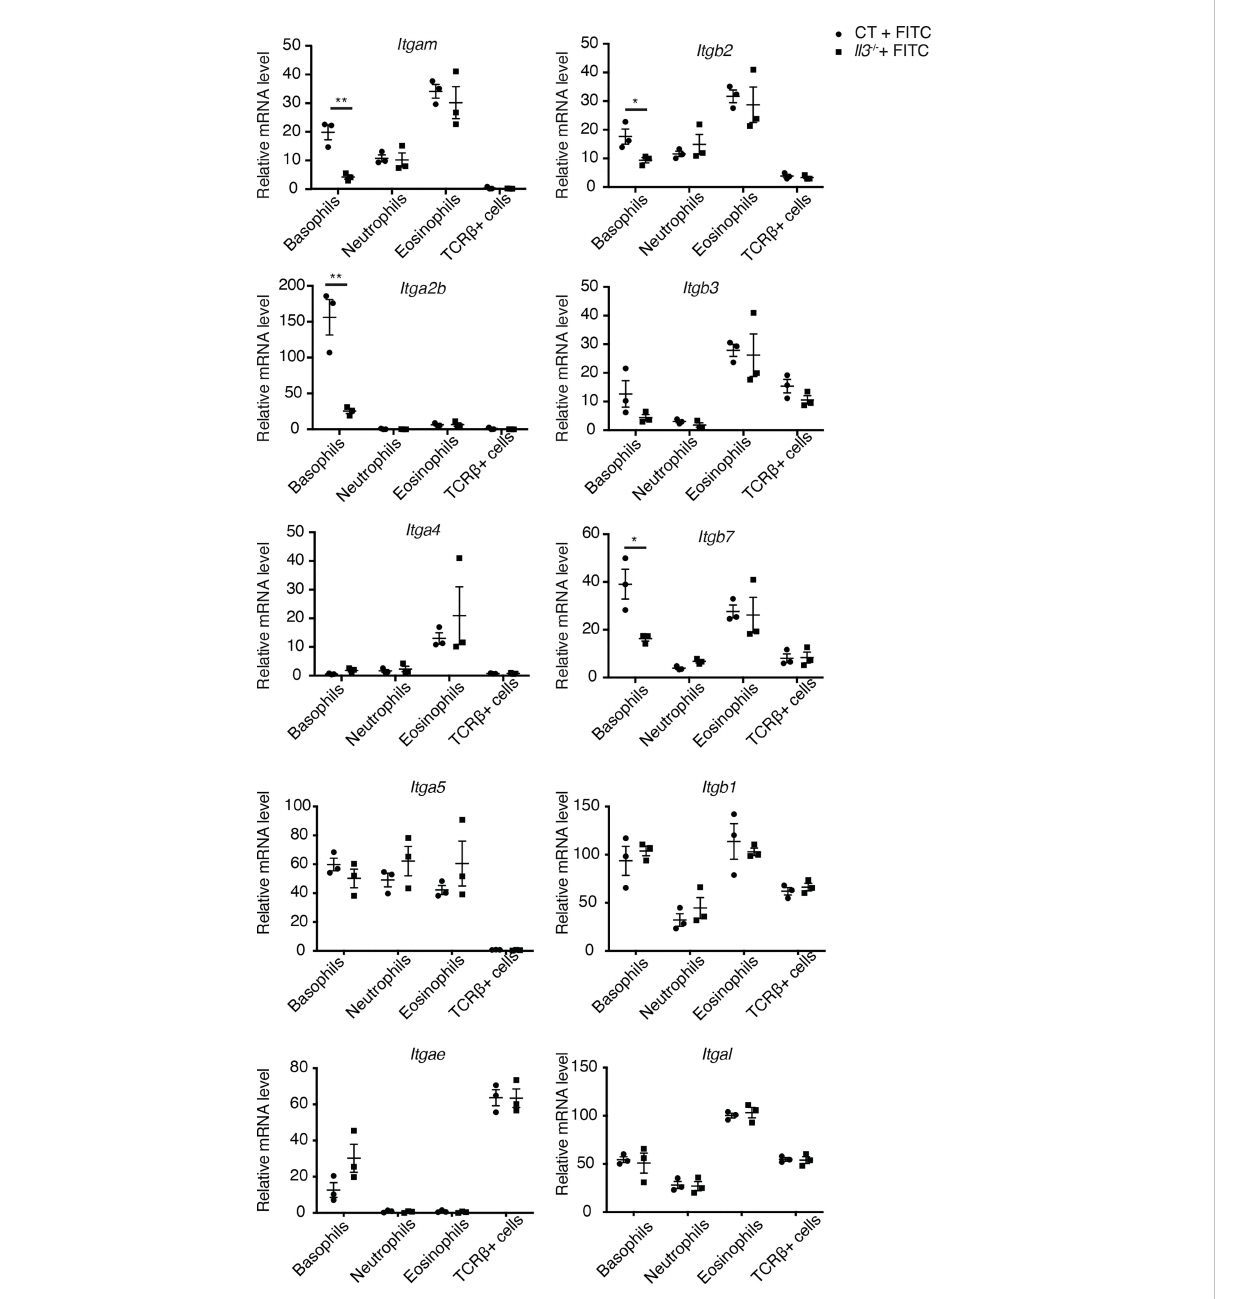
FIGURE 5 Decreased expression of integrins by basophils sorted from FITC-treated Il3 -/- skin. RT-qPCR analyses of the sorted basophils, neutrophils, eosinophils and TCR b + T cells. CT, wildtype controls. *P ≤ 0.05 **P ≤ 0.01 (Student's t-test). Values are mean ± SEM (n=3 mice per